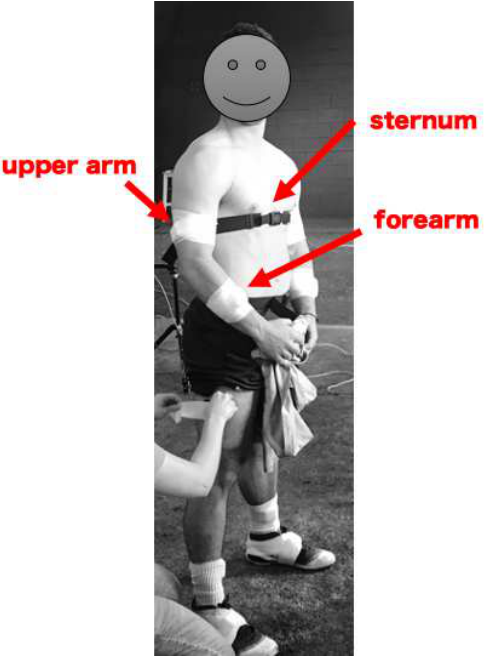
Figure 1. Illustration of sensor placement on the forearm, upper arm, trunk, and feet. The trunk sensor was placed on the sternum at the level of the xyphoid process, the upper arm sensor was placed at the posterolateral portion of the distal one-third of the segment, and the forearm sensor was placed at the mid-point of the segment. Placement location on each segment was determined by comfort for the pitcher and the location that appeared to produce minimal migration due to muscle contraction across multiple pitches. Arm and foot sensors were secured with flexible adhesive tape, while the trunk sensor was held in place by a snug chest strap. Table 1. Total throw count for each pitch type by player. Warm-up throws are included to provide a more comprehensive picture of the training session but were not included in analysis.